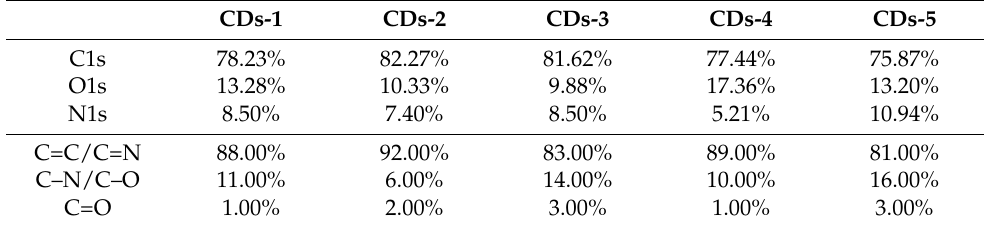
Table 1. Elemental proportions and chemical bonds in different CDs.